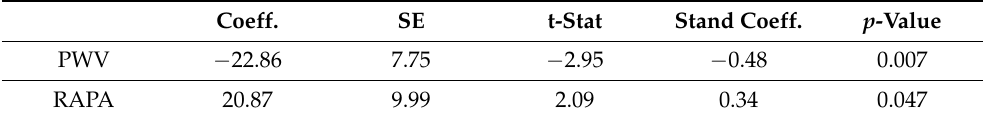
Table 3. CompBased-CAT/PWV/RAPA multiple linear regression (adjusted R 2 = 0.46; Cognifit = 433.605623 + 20.873369 RAPA − 22.85519 PWV).